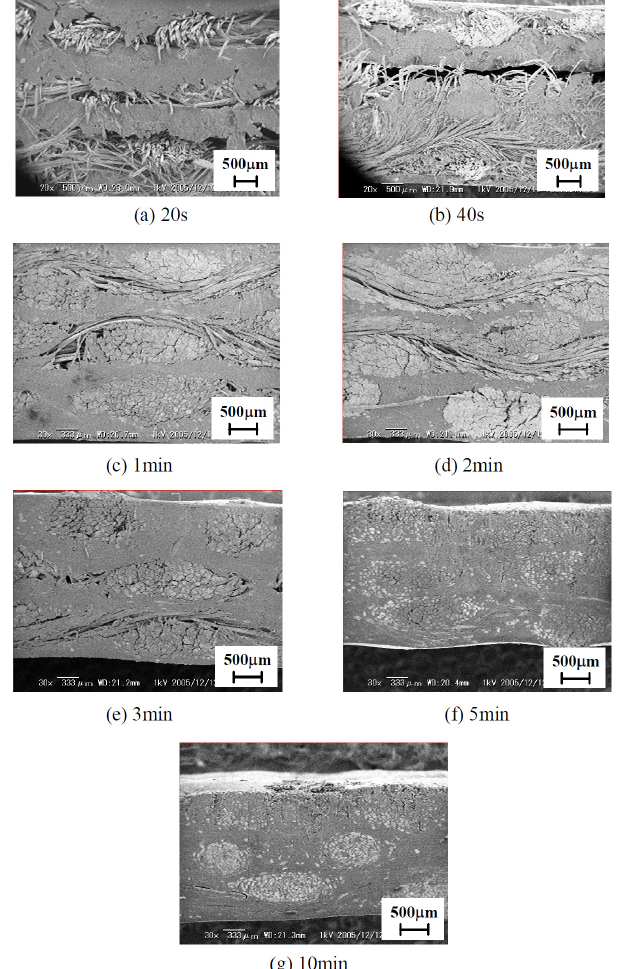
Figure 7. Cross section of JF-PLA laminate as a function of holding time: ( a ) 20 s, ( b ) 40 s, ( c ) 1 min, ( d ) 2 min, and ( e ) 3 min, ( f ) 5 min, and ( g ) 10 min. Reprinted from Reference [31] under Creative